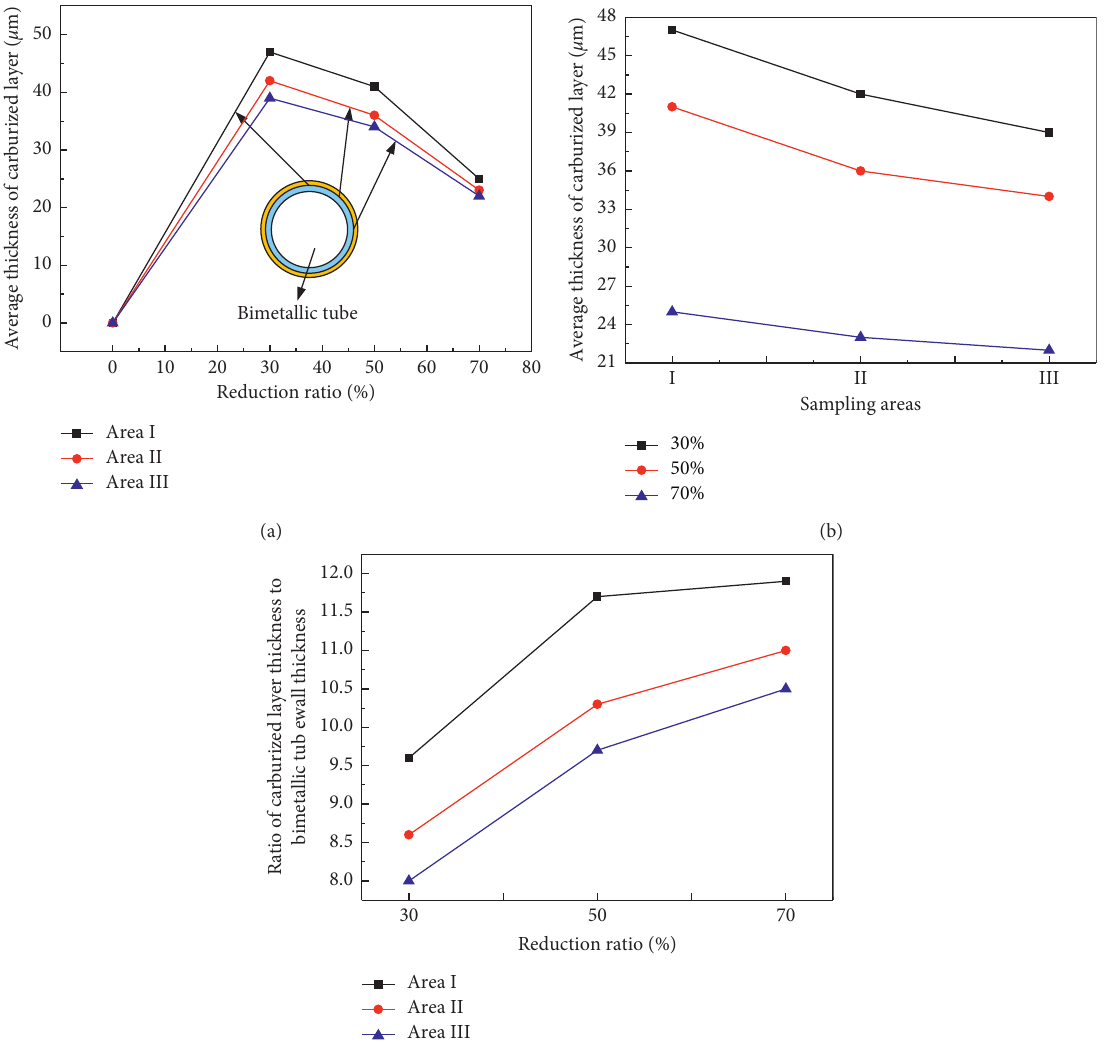
Figure 12: The variation of carburized layer thickness. (a) Different reduction rates. (b) Different sampling areas. (c) Ratio of carburized layer thickness to bimetallic tube wall